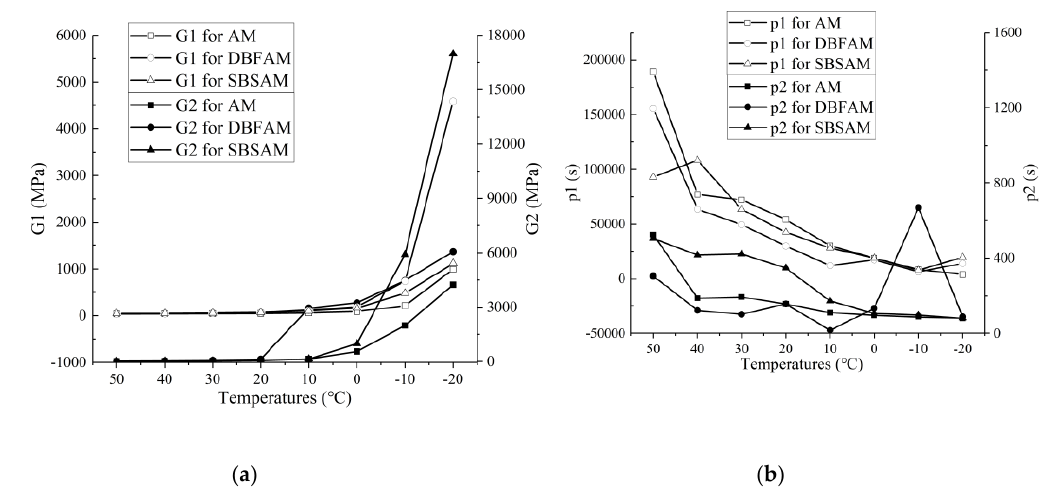
Figure 7. The trend of the relaxation parameters of the three asphalt mixtures with the test temperatures: ( a ) G 1 and G 2 ; ( b ) p 1 and p 2 .